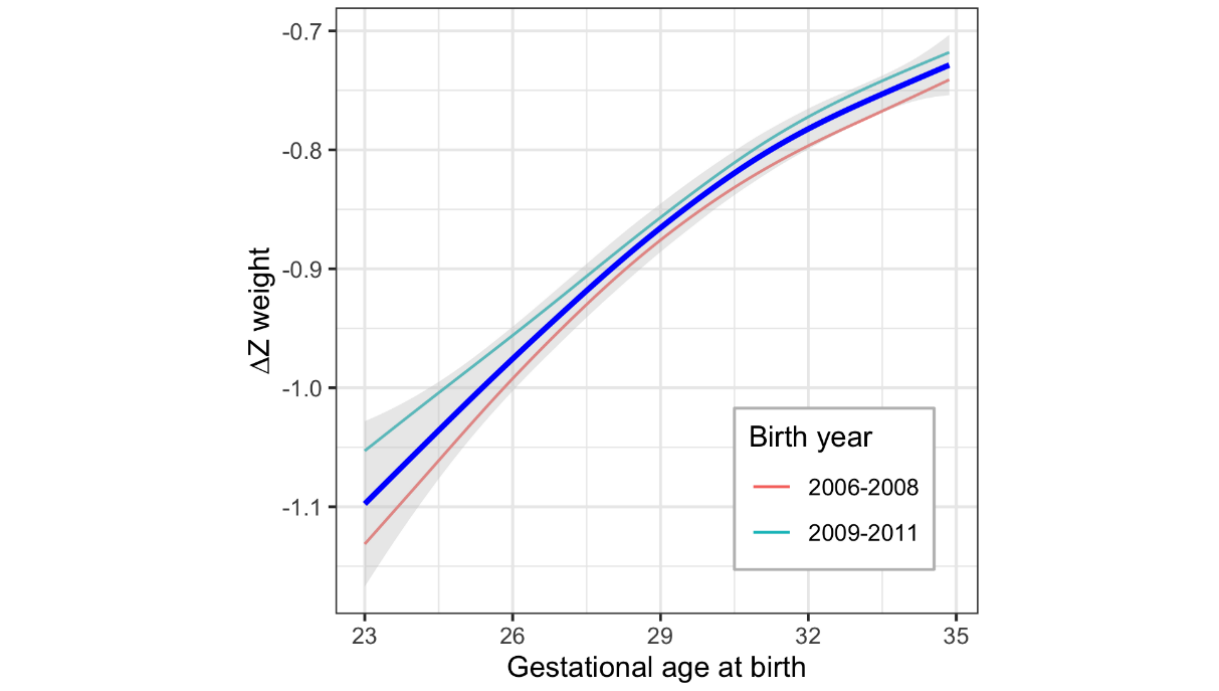
Figure 5. Change in weight Z-score from birth to discharge versus gestational age at birth, demonstrating inferior growth with increasing prematurity for all seven NICUs combined. The dark blue line is for all years 2006 - 2011 combined with the gray band representing the 95% confidence interval; the thin lines show the grouped birth years 2006 - 2008 versus 2009 - 2011.